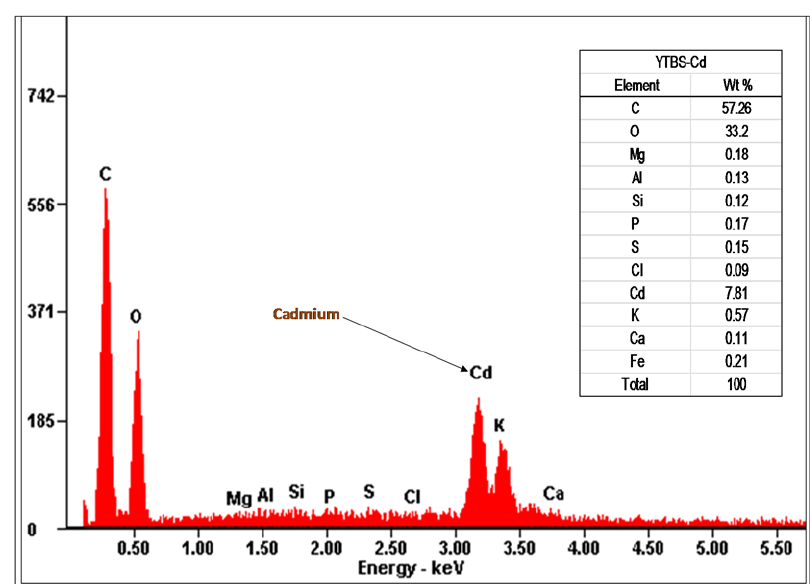
Figure 5. EDX spectrum of YTBS residue adsorbent after Cd(II) sorption.